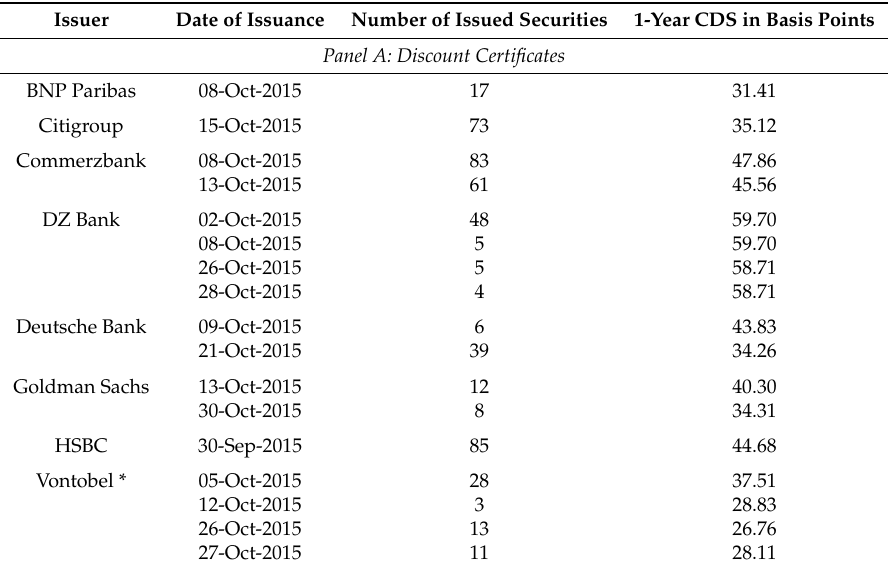
Table A1. Issue Dates, Number of Issued Securities and